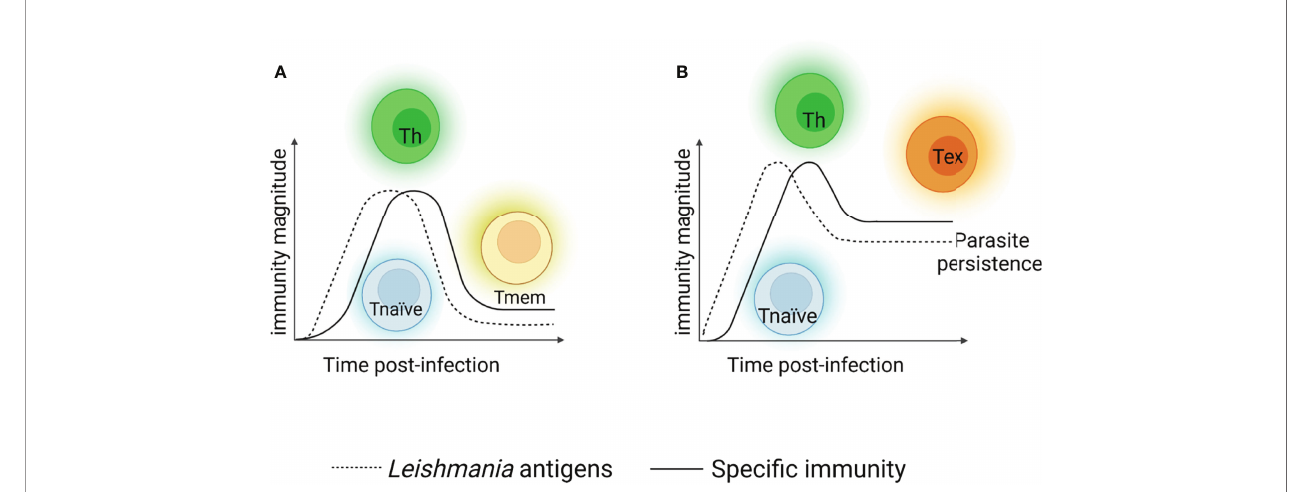
FIGURE 1 | T cell response after viscerotropic leishmania parasites recognition. When L. donovani or L. infantum antigens are recognized, speci fi c naïve CD4 + T cells (blue cells) are activated and differentiate into distinct subtypes of T helper lymphocytes (Th1, Th17 – green cells), restricting the parasites replication. After parasite declining, the most of Th cells die and the remaining cells differentiate into memory T cells (yellow cells). In the case of secondary exposure to the microorganism, memory T cells may be reactivated and promoting parasite control (A) . Situations where the speci fi c immune response generated in the host cannot control the parasite, a chronic infection process is established. The parasite ’ s persistence induces Thelper cells to enter a non-functional state, a term referred as exhaustion (represented by orange cells), rather than developing a classical memory cells. Exhausted T cells present a compromised effector functions and maintain the persistence of the parasites in the host for long periods, which re fl ects disease progression to more severe forms, but it was not found it in asymptomatic individual or patients with mild form of disease (B) . Created with BioRender.com (Agreement number: